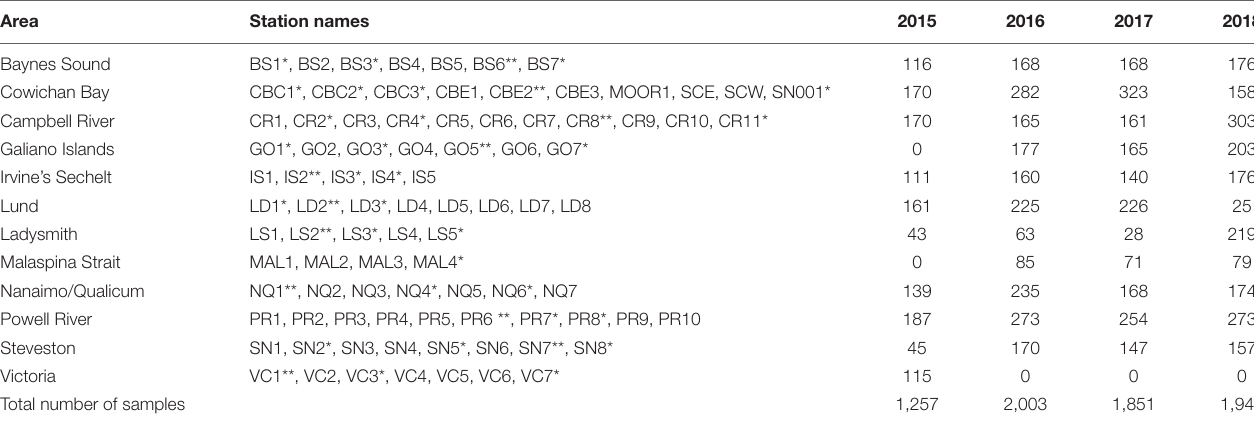
TABLE 1 | Sampling areas, stations, and number of phytoplankton